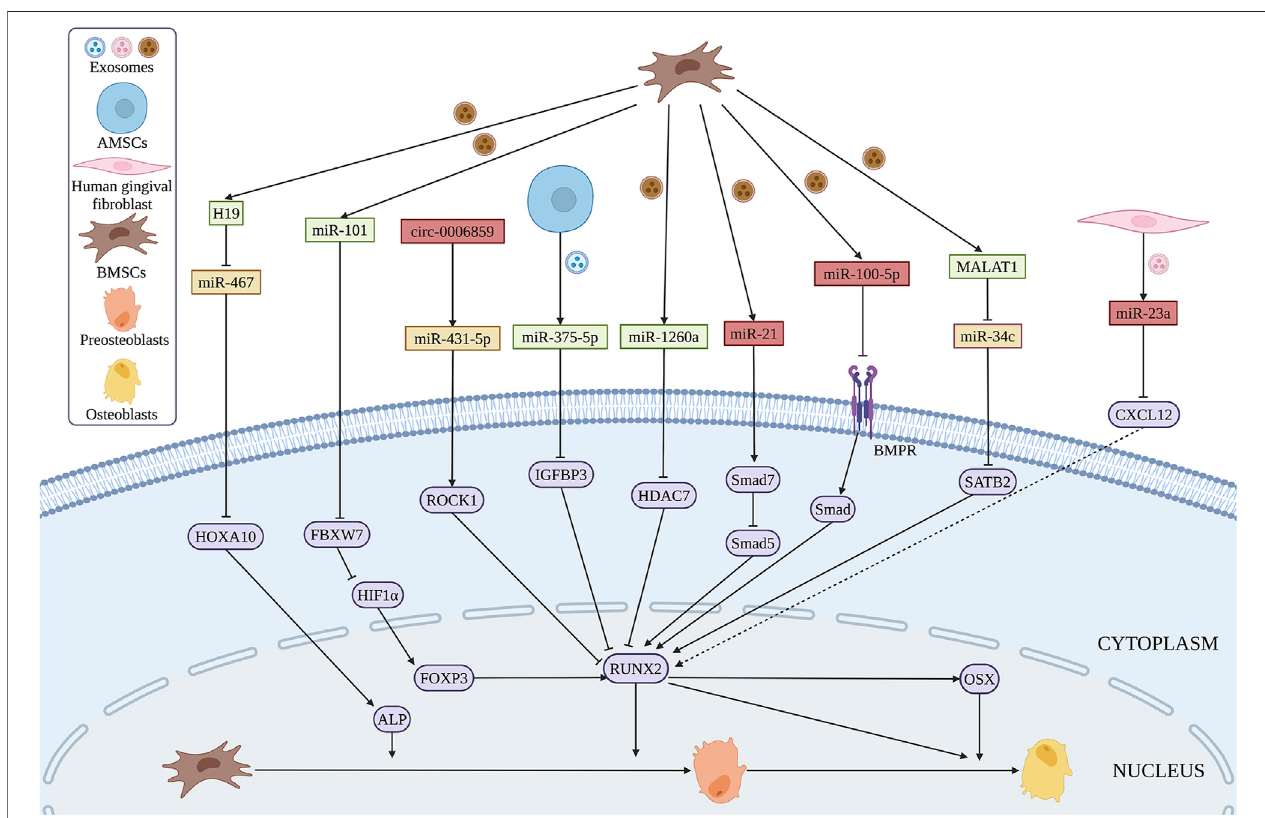
FIGURE 7 | Exosomal ncRNAs derived from BMSCs (brown), AMSCs (blue) and human gingival fi broblasts (pink) can promote (green) or inhibit (red) osteogenic differentiation of BMSCs via various regulatory mechanisms. (Created with BioRender.com).